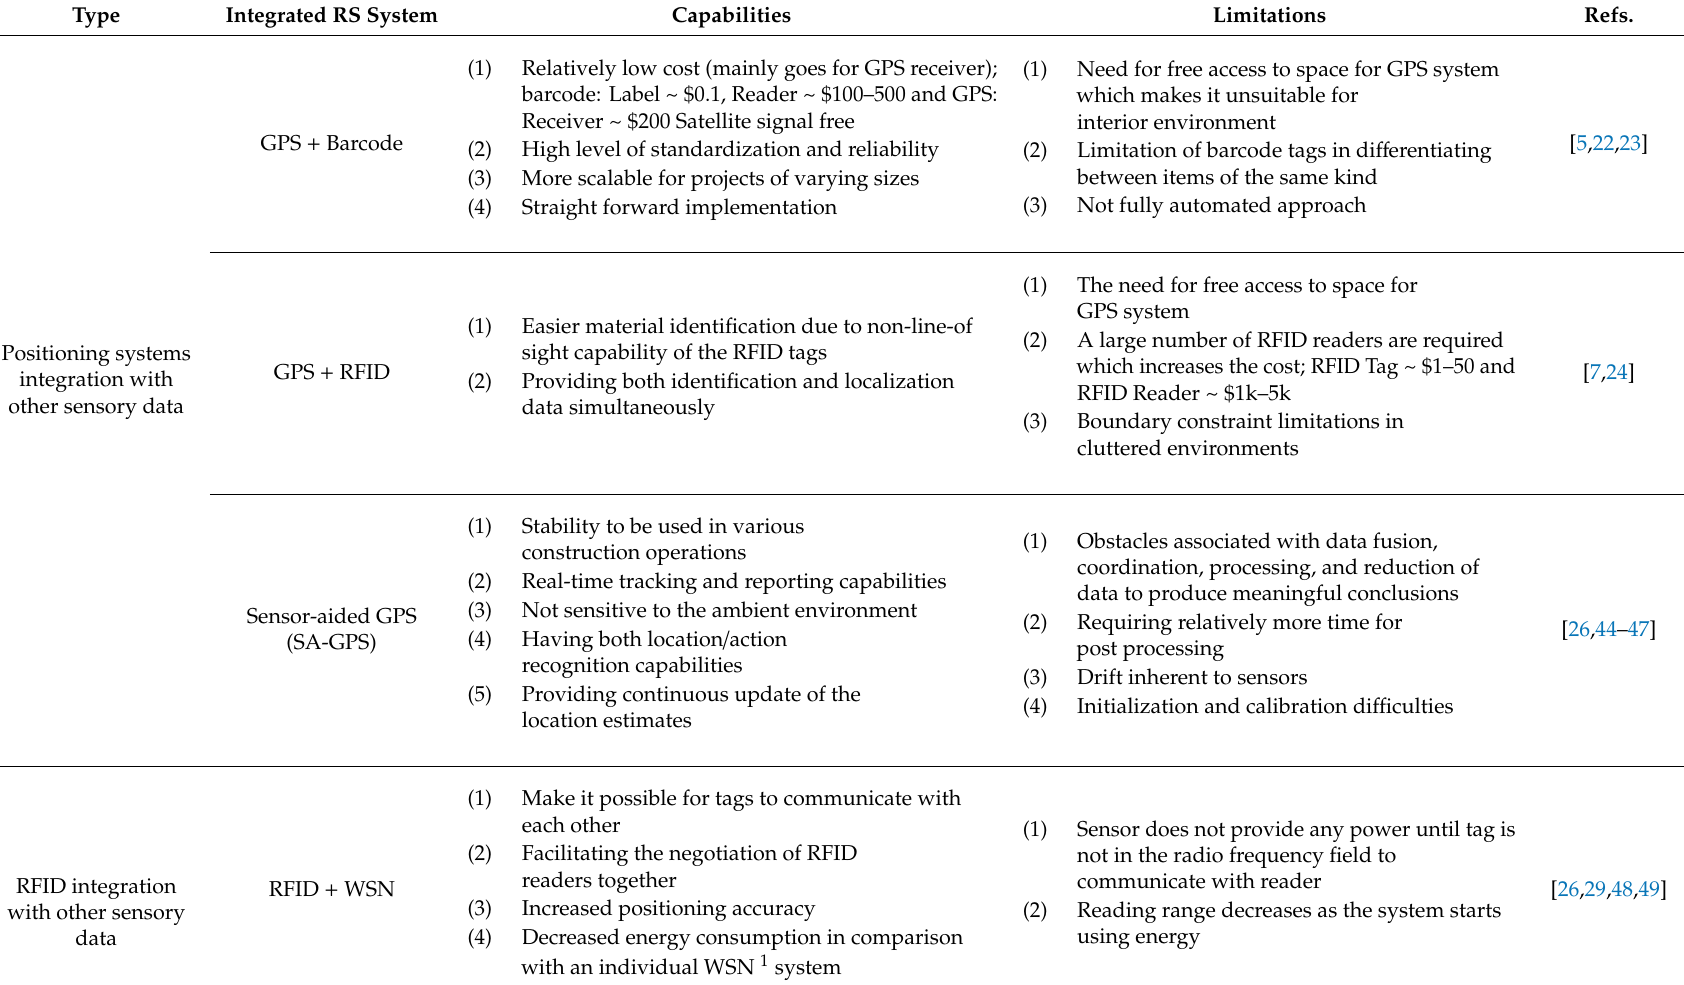
Table 3. Capabilities and limitations of integrated RS